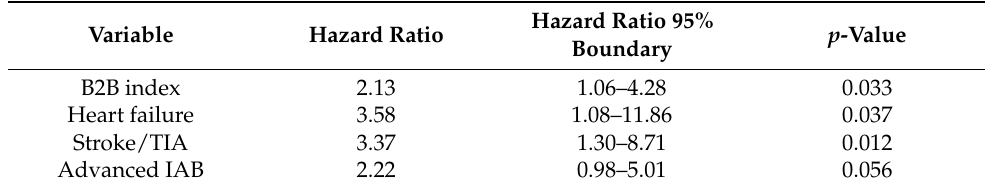
Table 6. Multivariable Cox regression analysis